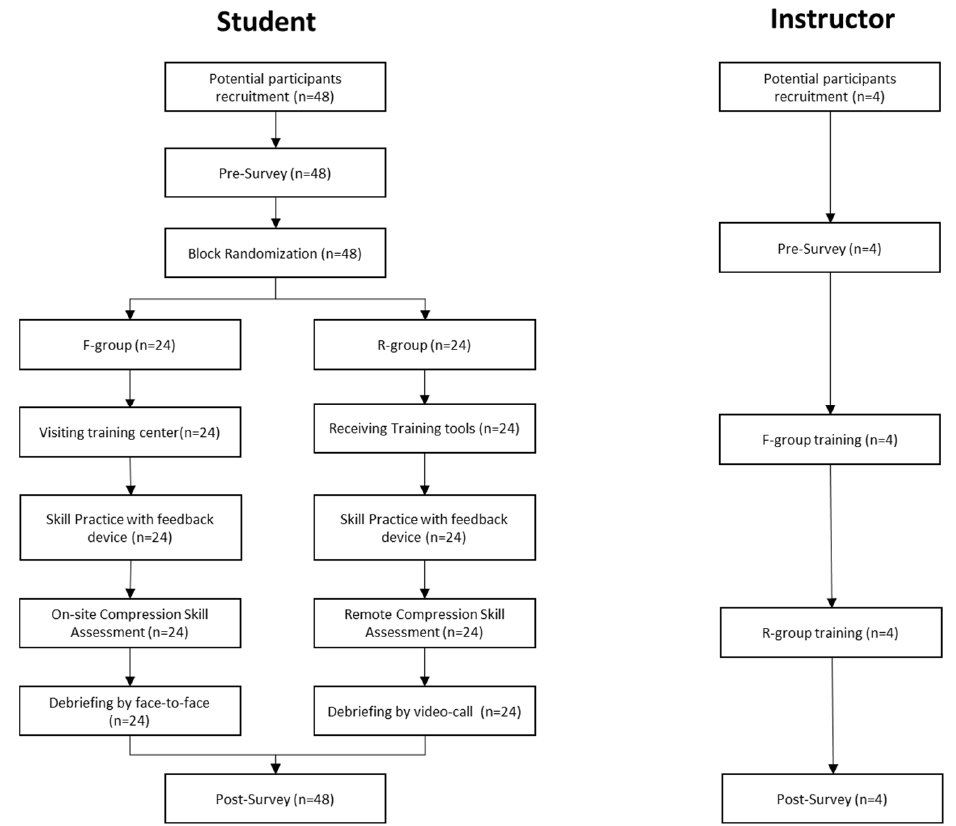
Figure 7. Overall procedures for Students ( left ) and Instructor ( right ).